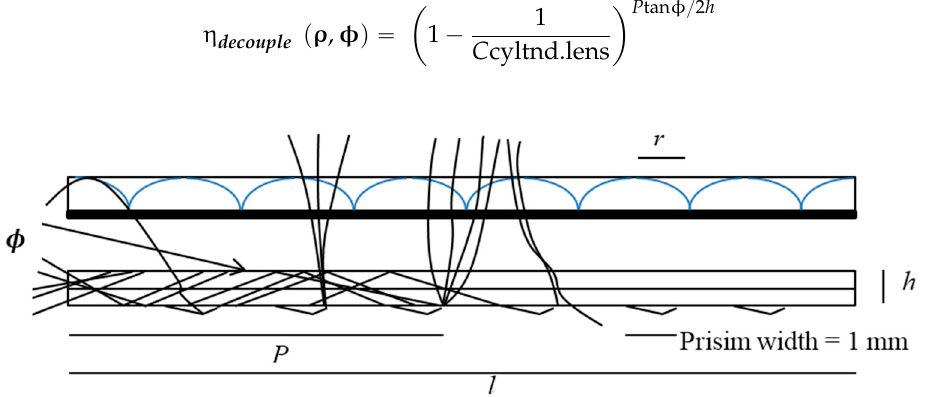
Figure 2. The optical waveguide’s parameters (Lateral section).